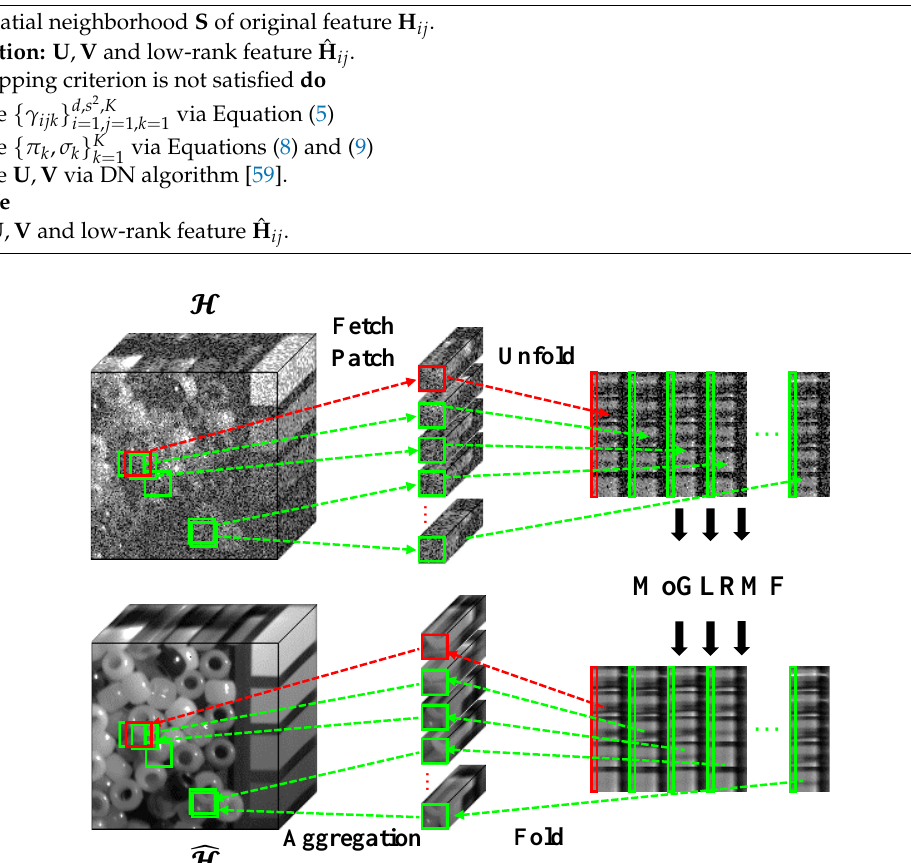
Algorithm 1 EM algorithm to extract the MoGLRMF feature.